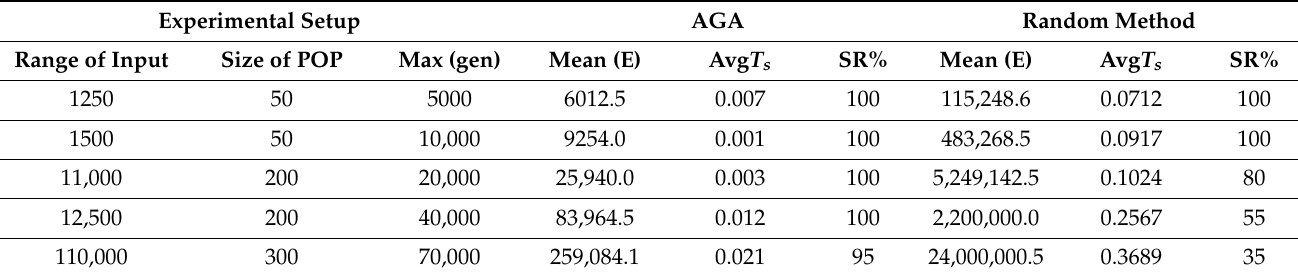
Table 3. Comparison of AGA and random